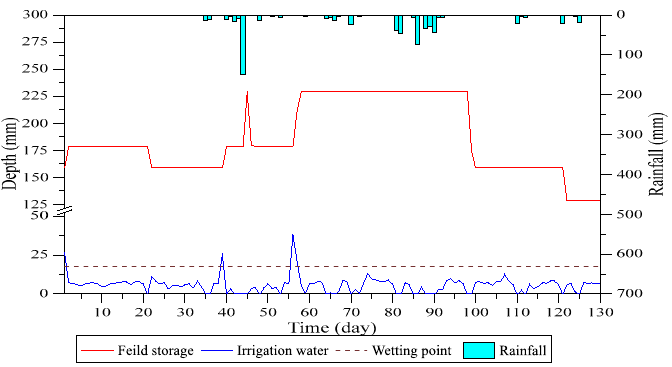
Figure 14. Irrigation, discharge, and rainfall simulation result of 30% reduction of planned irrigation water during the first crop season.